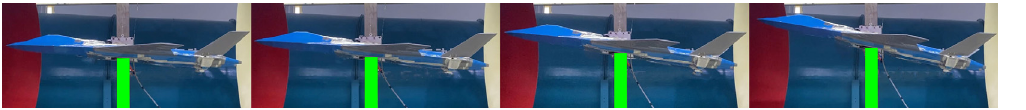
Figure 29. Height, pitch angle and tail deflection angle time history curves at wind speed 24 m/s and the target height was 110 mm.